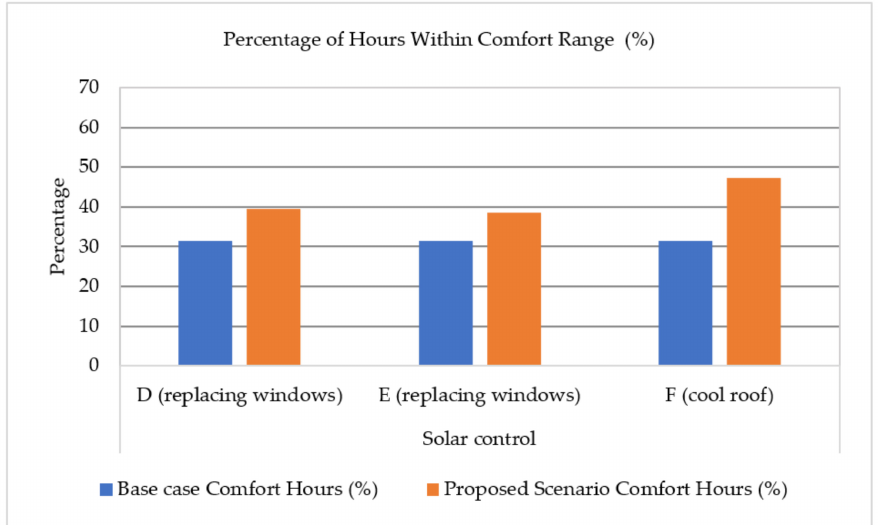
Figure 6. A comparison between the comfort hours in the base case and the proposed solar control